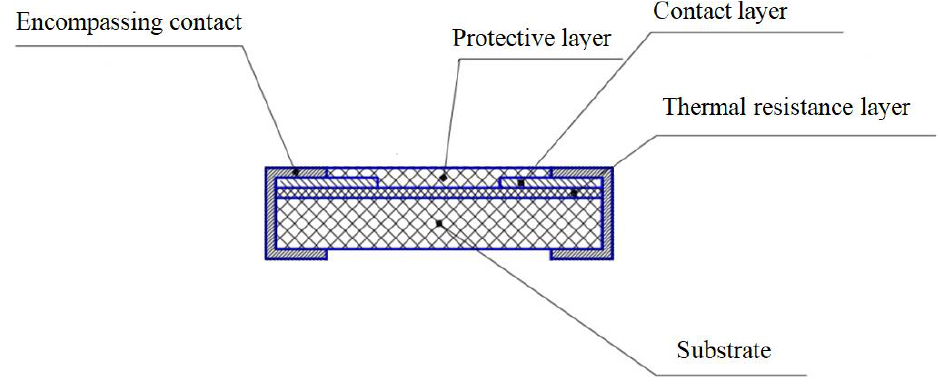
Figure 4. Schematic representation of the thermistor chip in planar geometry.